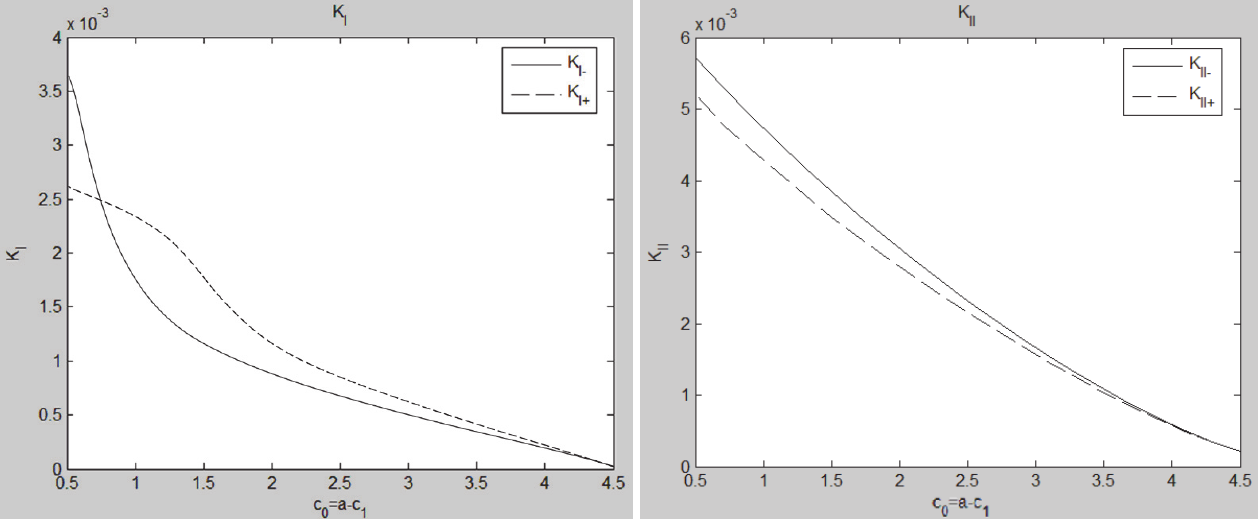
K K when the crack’s size is I II